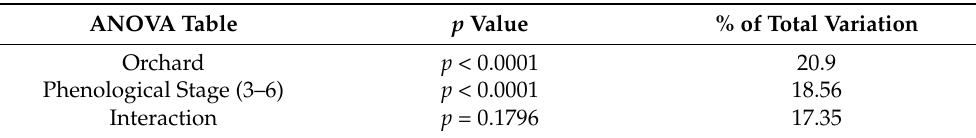
Table 1. ANOVA of the off-flavor incidence in sweet cherries cv. Regina with orchard and phenological stage as factors.